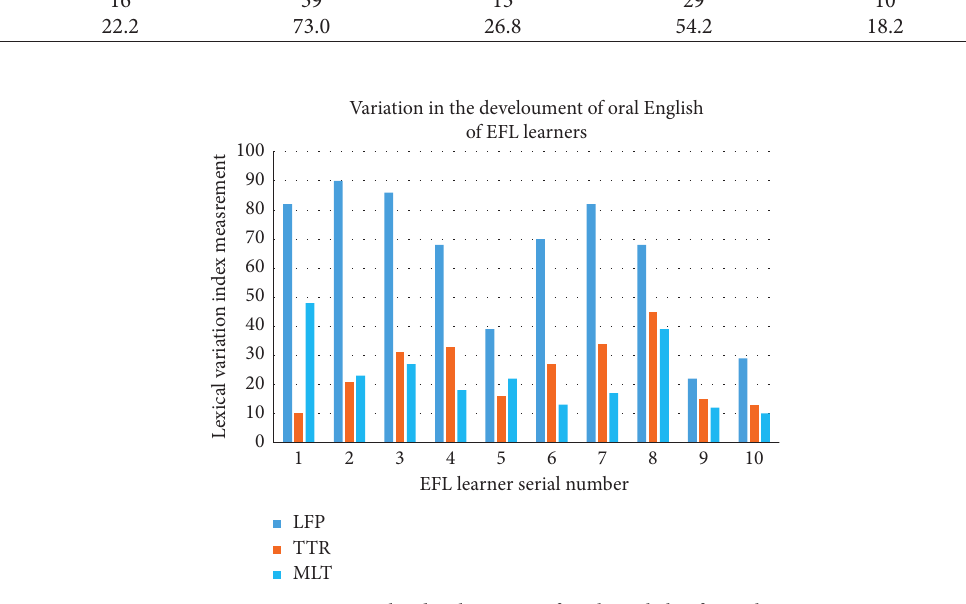
Figure 4: Variations in the development of oral English of EFL learners. Table 5: Communicative willingness of some learners who participated in the experiment.